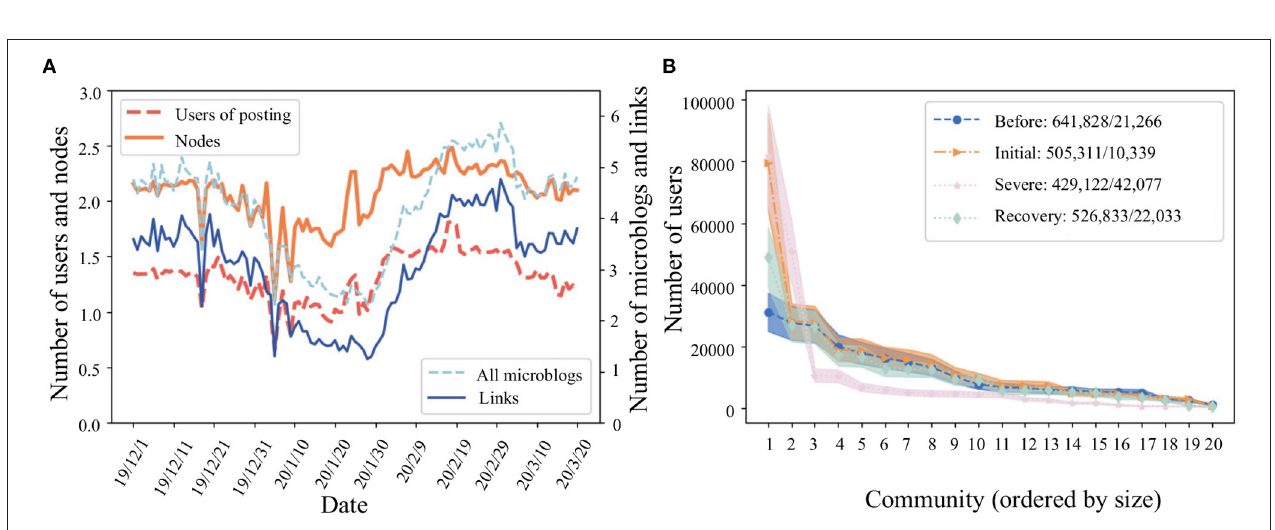
FIGURE 4 | (A) Overview of the posting activity. (B) Size of the top 20 network communities during the four stages. The number of communities and the number of links between communities are shown before and after “/” in the legend.